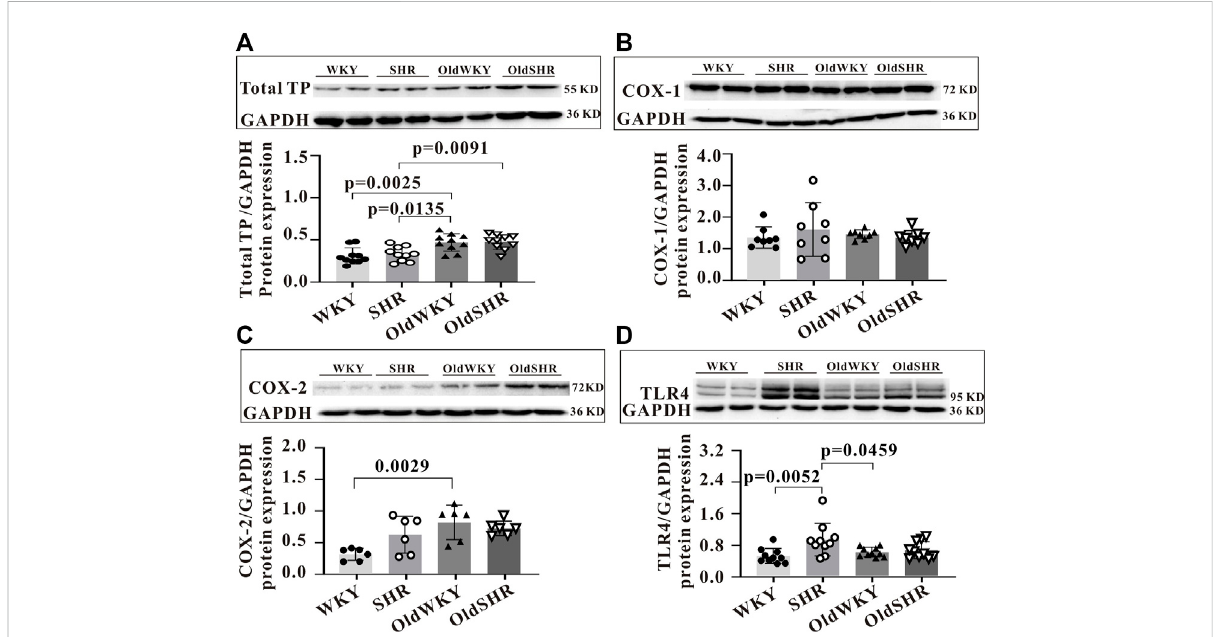
FIGURE 5 Expression ofprostaglandin signaling pathway-related proteins. (A) TotalTPproteinexpression,showingasigni fi cantly increased expression of TP in SHR, OldWKY, and OldSHR rats. (B,C) COX-1 and COX-2 protein expression, showing a signi fi cantly increased expression of COX-2 in SHR, OldWKY, and OldSHR rats. (D) TLR4 protein expression, showing a signi fi cantly increased expression of TLR4 in SHR and OldWKY rats. Intact mesentery arteries were collected from 5 – 6 rats in each